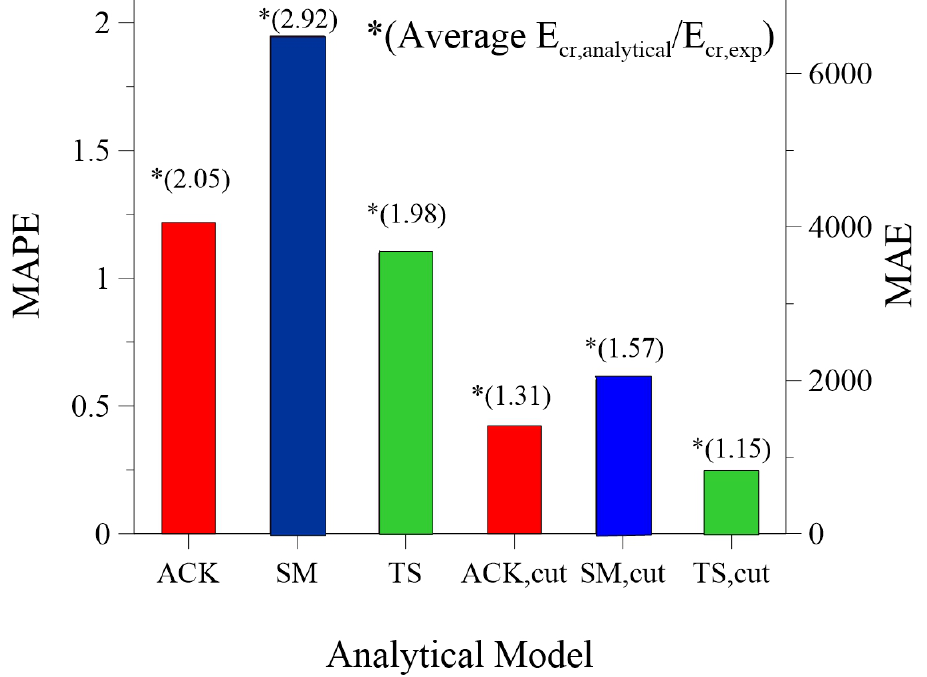
Figure 12. Mean Absolute Error (MAE) and Mean Absolute Percentage Error (MAPE) measures for the analytical models: ACK, SM, TS, ACK, cut, SM, cut, TS,